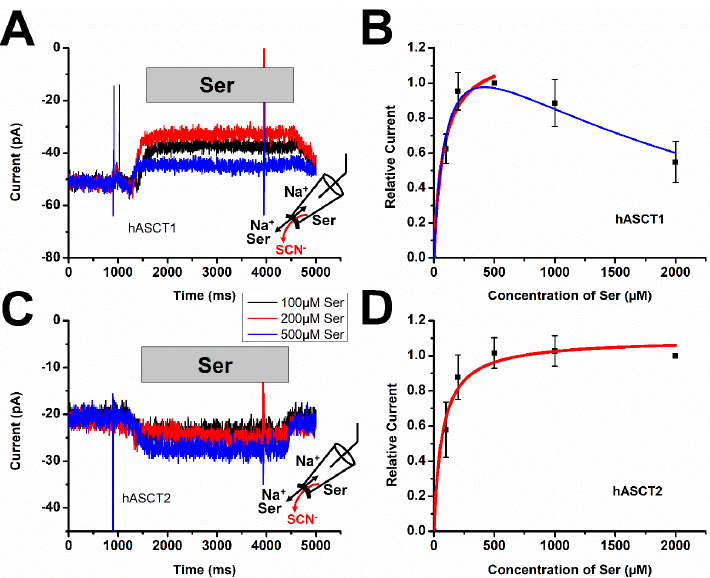
Figure 3. Determination of substrate apparent affinity of the inward-facing state. Representative whole cell current recordings from ASCT1 ( A ) and 2 ( C ) transfected cells in the inside-out patch configuration. The extracellular solution (pipet solution) contained 130 mM NaSCN with 10 mM Ser. The intracellular (bath) solution contained 140 mM NaMes with varying concentrations of serine. ( B ) Concentration dependence of serine-induced current for determining the apparent affinity for serine of the inward-facing state ( K m = 77 ± 34 µ M with one site binding fitting equation, or K 1 = 105 ± 12 µ M, K 2 = 2400 ± 200 µ M for two binding site fitting for ASCT1). ( D ) Determination of apparent affinity of serine of the inward-facing state with a K m of 70 ± 18 µ M for